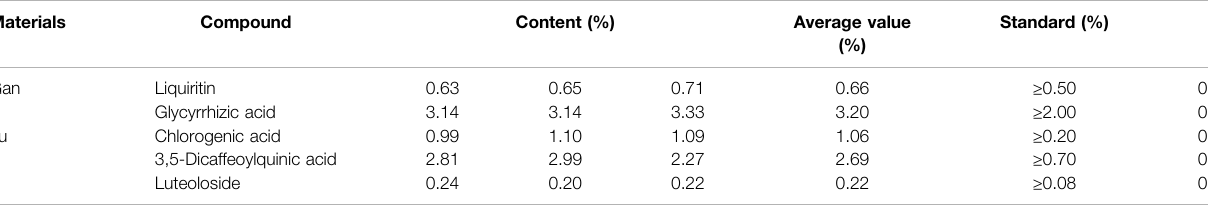
TABLE 4 | Compounds content in herbal Gan and Ju.